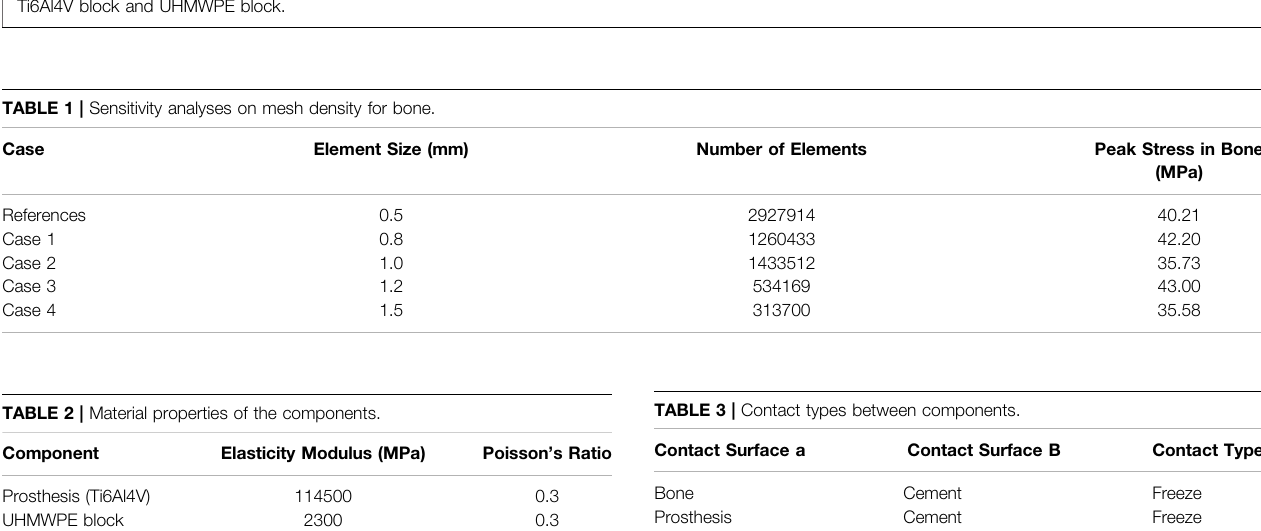
FIGURE 2 | The fi nite element models of all components. (A) Porous Ti6Al4V block and customized prosthesis assembled to simulate the operation. (B) CCK prosthesis. (C) customized prosthesis which includes aUHMWPEblock. (D) Porous Ti6Al4V block. (E, F) Distal femurosteotomy models, which are paired with porous Ti6Al4V block and UHMWPE block.